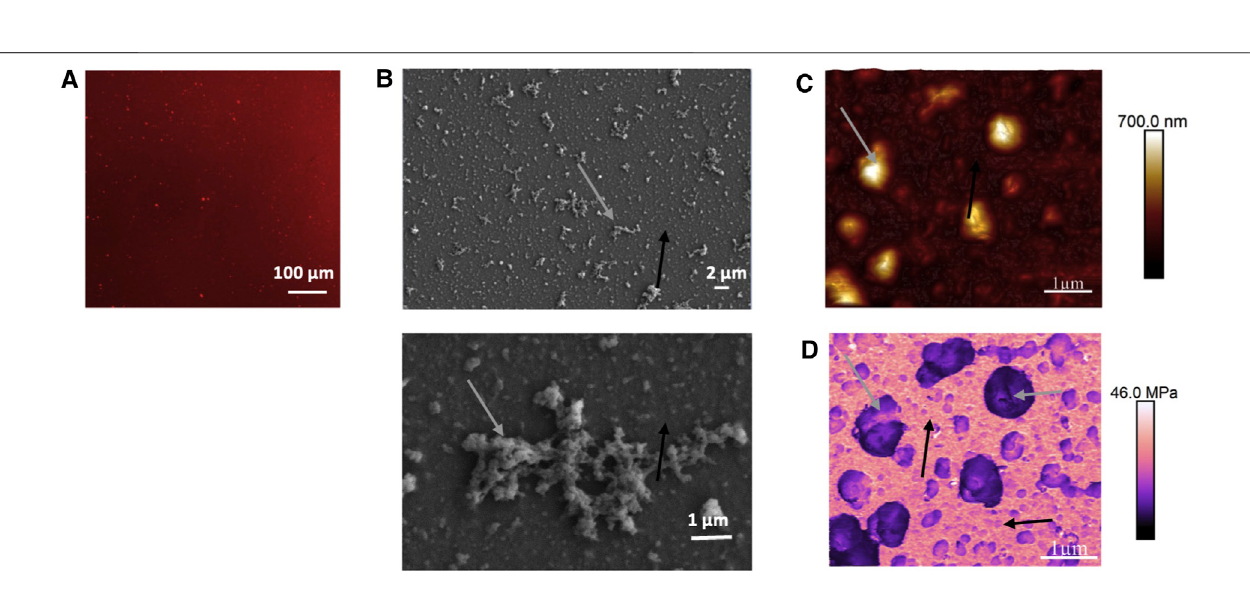
( Figure 2D ). The images obtained exhibit high rigidity of the homogeneous fi lm distributed around the aggregates (up to 46 MPa Figure 2D , black arrows), whereas aggregates show lower rigidity values (5 – 30 kDa Figure 2D , gray arrows). Such large structures were already observed with HMW PLL and could result from molecule self-assembly (protein or polyelectrolyte polymers) (Gand et al., 2017). The Young ’ s modulus values obtained are in accordance with values of protein aggregates that could range from 15 to 30 MPa (Lam and Ikeda 2017) which is lower than values obtained when proteins are self-assembled into fi brils (GPa) (Gilbert et al., 2017).